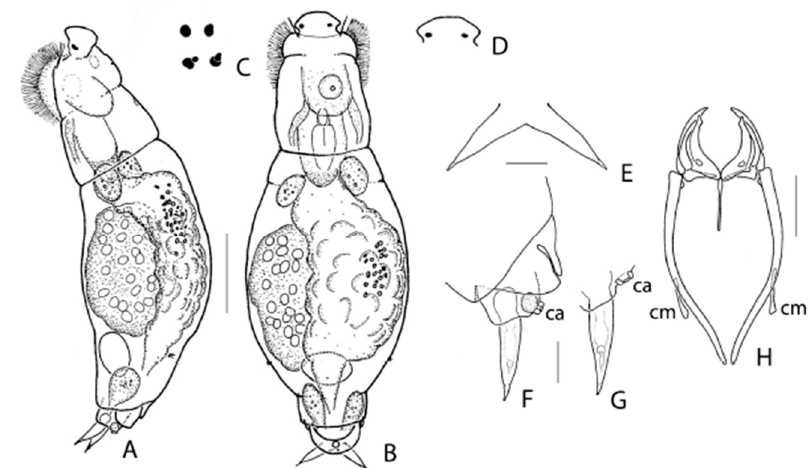
Figure 4. Encentrum rousseleti (Lie-Pettersen, 1905). ( A ) Female (slightly contracted), lateral. ( B ) Female, dorsal. ( C ) Eyespots (left), different shapes. ( D ) Rostrum, detail, dorsal. ( E ) Toes, dorsal. ( F , G ) Toes, lateral left. ( H ) Trophi, dorsal. ca: caudal antenna; cm: calcar manubrii. Scale bars: ( A , B ): 50 µm; ( E – G ): 10 µm.